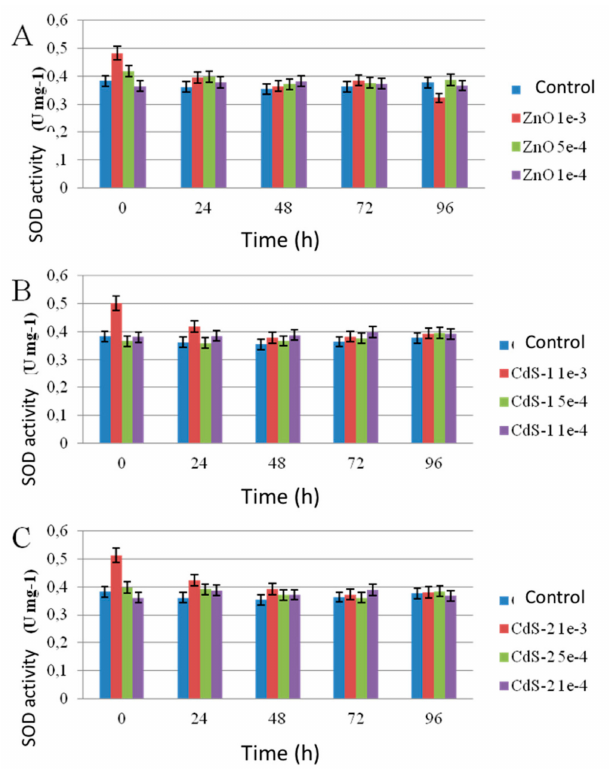
Figure 15. Superoxide dismutase (SOD) activity after contact with Chlorella vulgaris in the presence of ( A ) ZnO, ( B ) CdS-1, and ( C ) CdS-2 in Seine river water as a function of the nanoparticles concentration and